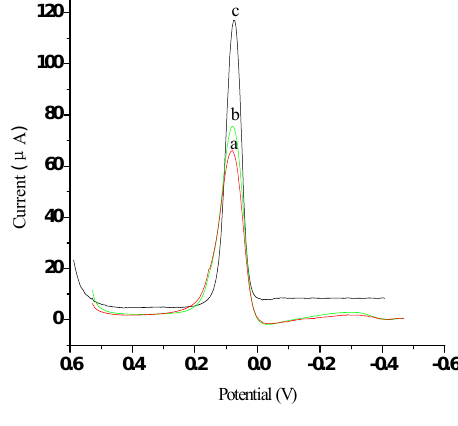
Figure 7. The characterization of signal amplification by different labels: ( a ) Bare GE; ( b ) Modified AFP Ab2-HRP; ( c ) EVC-AFP Ab2. Scan rate 50 mV/s, in 0.01 mol/L PBS/0.1 mol/L KCl (pH 7.4) and added 5 mmol/L